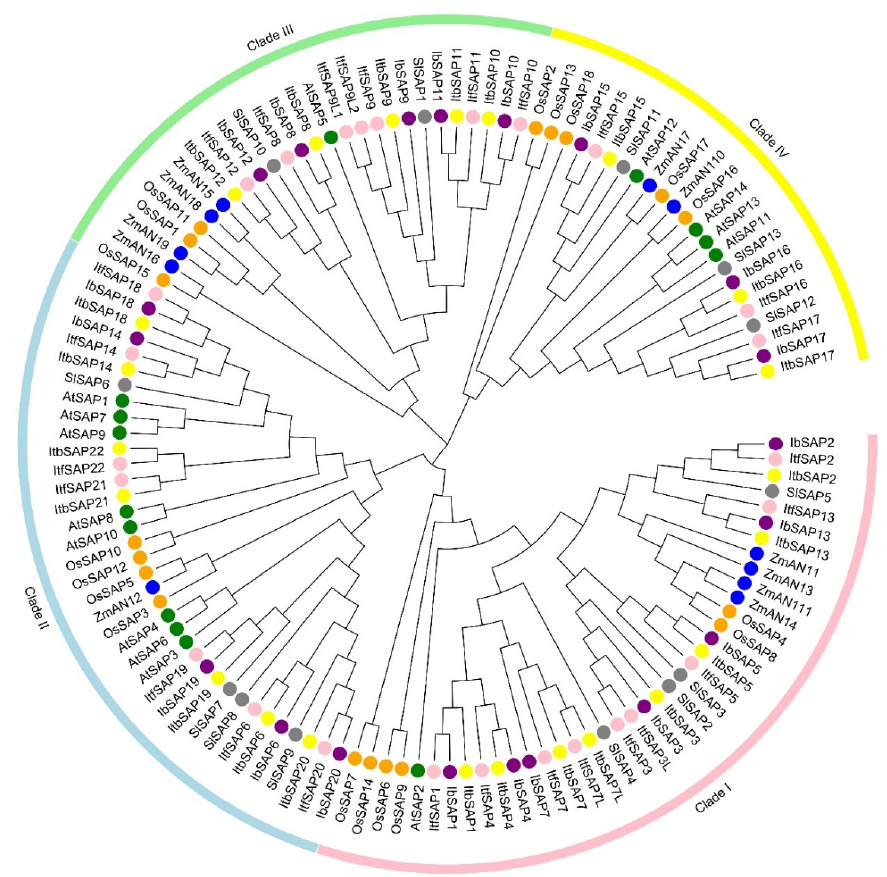
Figure 2. Phylogenetic relationship of stress-associated proteins (SAPs) from I. batatas , I. triloba , I. trifida , Arabidopsis thaliana , Oryza sativa , Solanum lycopersicum , and Zea mays . A total of 125 SAPs were divided into four clades (clade I to IV). The cycles filled with purple, yellow, pink, green, orange, grey, and blue represent SAPs in I. batatas (IbSAPs), I. triloba (ItbSAPs), I. trifida (ItfSAPs), A. thaliana (AtSAPs), O. sativa (OsSAPs), S. lycopersicum (SlSAPs), and Z. mays (ZmAN1s), respectively. The